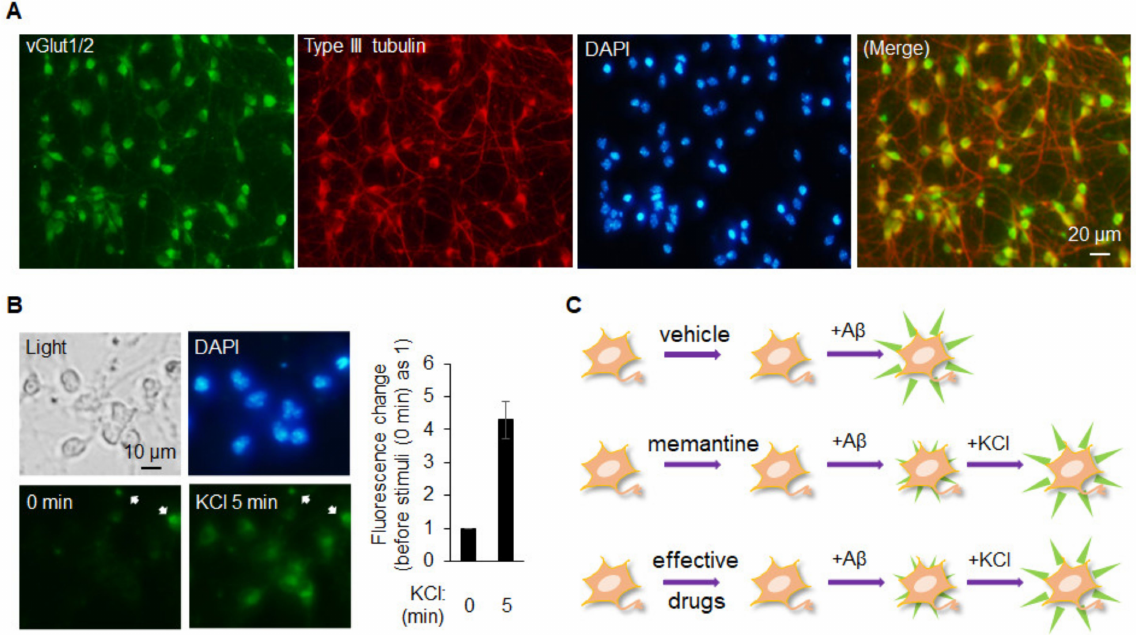
Figure 3. Glutamatergic neurons differentiated from ESCs could provide an alternative resource for establishing the drug screening system/platform: ( A ) neurons differentiated from mESCs for around 7 days were fixed and immunocytochemistry was performed using vGLUT1/2 or type III tubulin as the primary antibody. A merged image of vGLUT1/2 (green) and type III tubulin (red) is shown; ( B ) neurons differentiated from mESCs were incubated with 1 µ M DiBAC4(3), a slow- response voltage sensitive fluorescent dye, for 30 min in KRH solution prior to the experiment. The fluorescent intensity was monitored and recorded every minute after 45 mM KCl was added to the solution. Only the images before (0 min) and after (5 min) the stimulation are shown here. The arrows indicate the nonspecific signals which are used as controls for fluorescent intensity. Intensity changes were quantified, plotted and are shown on the right panel. Data are shown as means ± SD; ( C ) a cartoon is drawn schematically to indicate the use of these neurons for drug screening platform. Top panel, A β 1-42 -induced abnormal depolarization will be observed. Middle panel, memantine, a drug used as part of the clinical treatment of AD patients, shall be able to block the A β 1-42 -induced abnormal depolarization. At the end of experiment, these neurons shall be stimulated with KCl to confirm their responsiveness. The use of memantine functions as a positive control for the platform. Bottom panel, the effective drugs can be screened by using the same logic with the one in